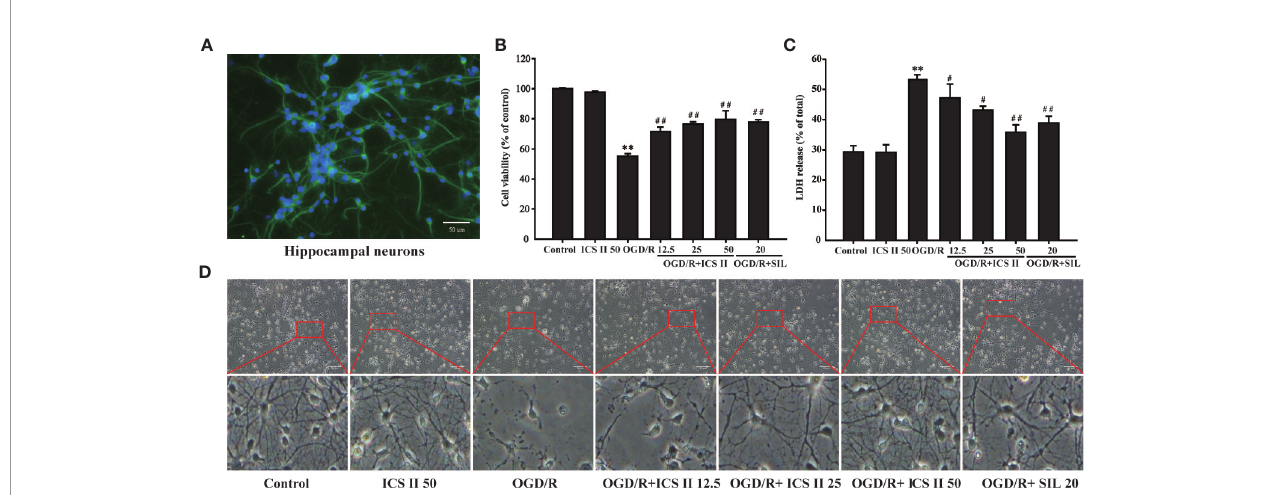
FIGURE 1 | ICS II protected against OGD/R-induced primary hippocampal neurons injury. (A) After 8 d cultured, NSE was labeled on hippocampal neurons, further observed by fl uorescence microscope. (B) Neurons were induced by OGD 1.5 h then reperfusion 24 h, different concentrations of ICS II (12.5, 25, or 50 m M) were administrated during the reperfusion, and the cell viability was determined by MTT assay. (C) LDH release from hippocampal neurons was measured using an LDH release assay. (D) The protective effects of ICS II on OGD/R-induced morphological alternation. Data are presented as means ± SD (n = 3). ** P < 0.01 versus control group; # P < 0.05, ## P < 0.01 versus OGD/R